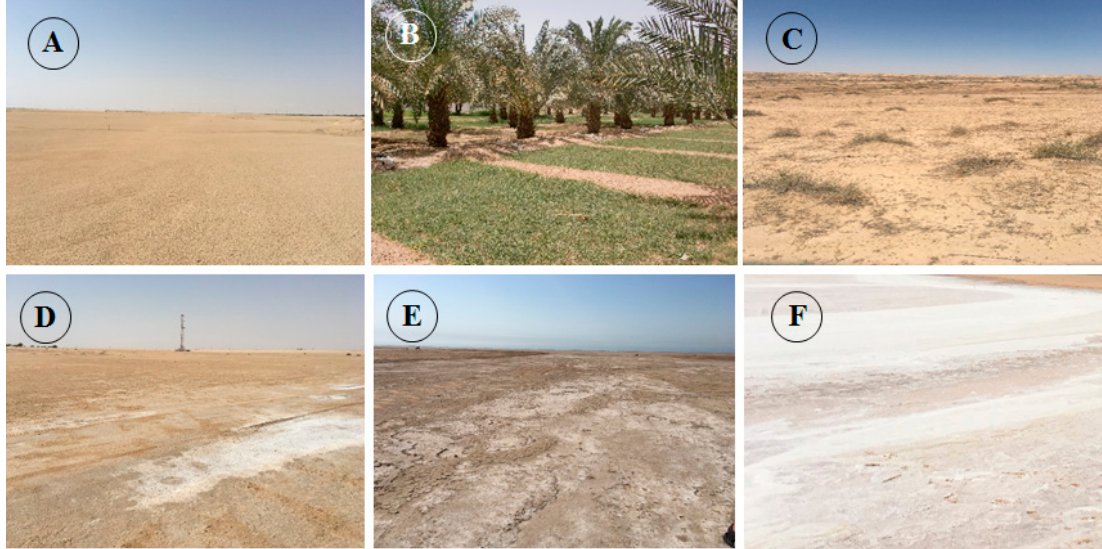
Figure 3. Photos illustrating the six considered soil salinity classes: ( A ) non-saline, ( B ) low, ( C ) moderate, ( D ) high, ( E ) very high and ( F ) extreme salinity which is Sabkha. ( D ) high, ( E ) very high and ( F ) extreme salinity which is